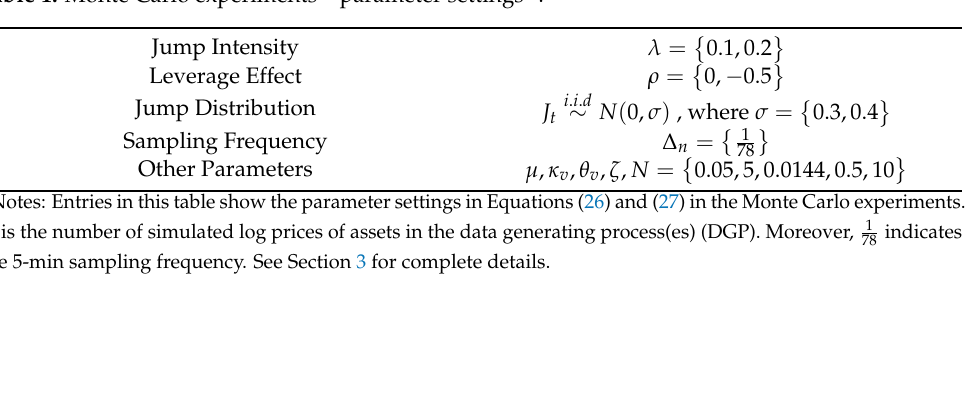
Table 1. Monte Carlo experiments—parameter settings